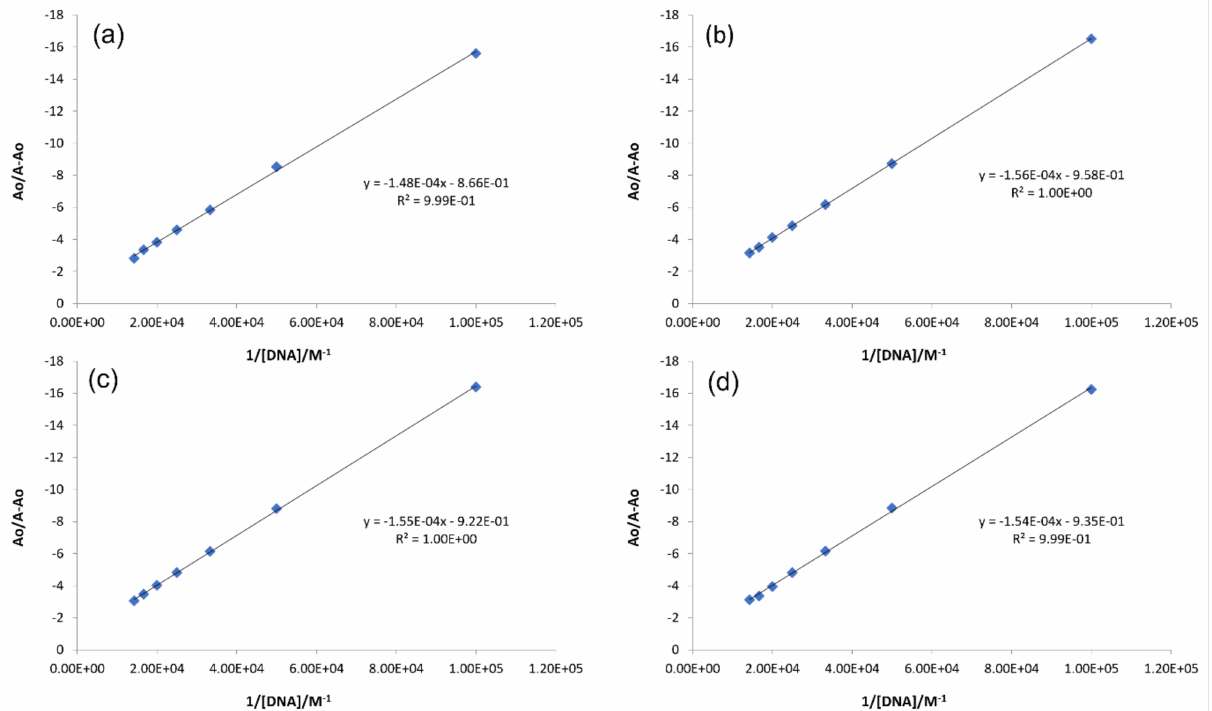
Figure 7. Graphs for the calculations of the binding constant using Equation (2) for compound DNA complex. ( a ) IST-01–DNA, ( b ) IST-02–DNA, ( c ) IST-03–DNA, ( d )